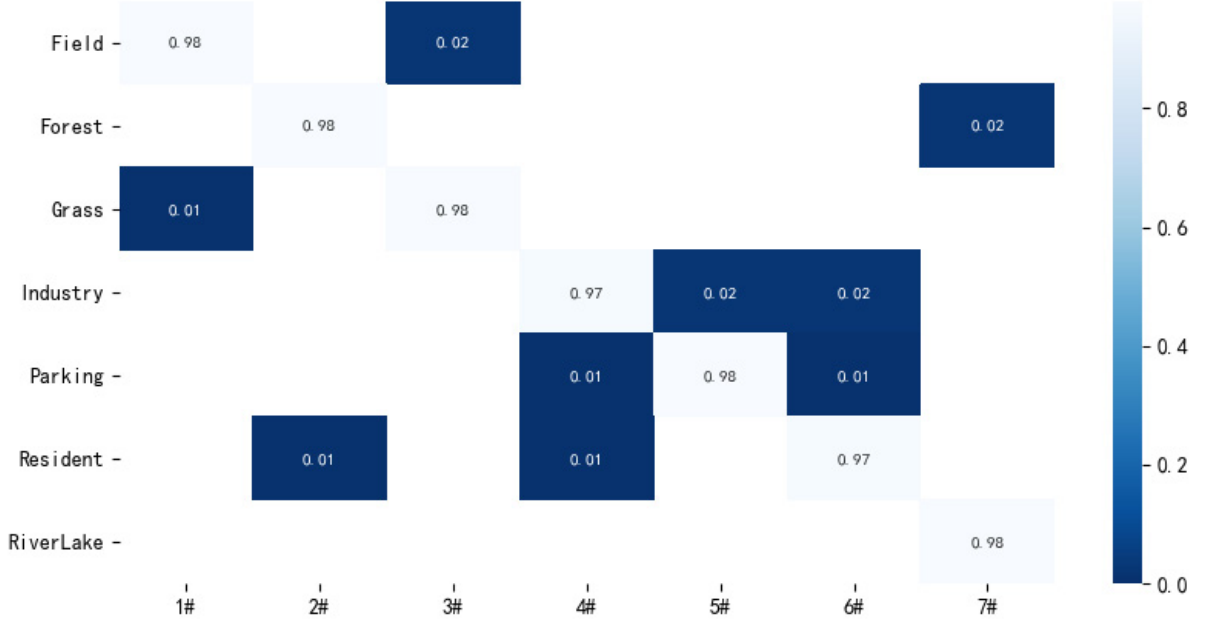
Figure 11. Confusion matrix of the proposed method on RSSCN dataset with 50% training ratio.